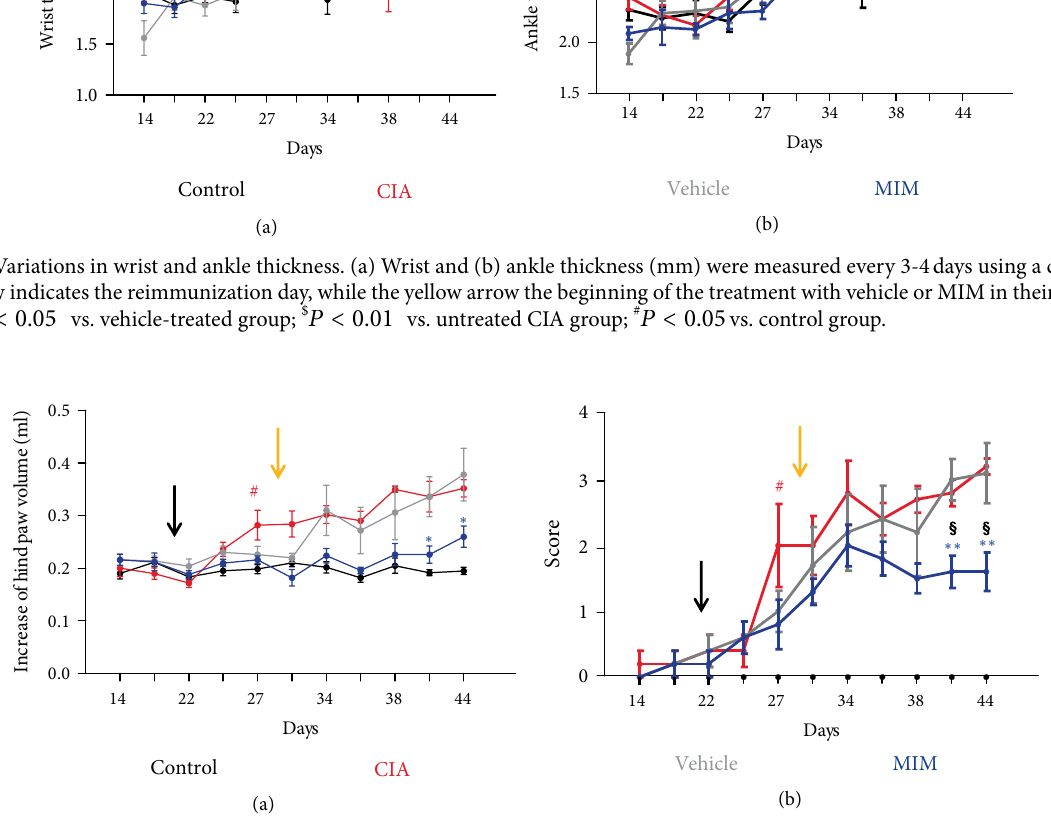
Figure 3: Variations in paw edema and clinical score. (a) Paw edema was measured as an increase in volume (ml), every 3-4 days using a plethysmometer. The black arrow indicates the reimmunization day, while the yellow arrow the beginning of the treatments. ∗ 푃 ≤ 0.05 vs. vehicle-treated group; # 푃 < 0.05 vs. control group. (b) Clinical score was attributed every 3-4 days for subjective evaluation of arthritis severity. The black arrow indicates the reimmunization day, while the orange arrow the beginning of the treatments. ∗∗ 푃 < 0.01 vs. vehicle-treated group; § 푃 < 0.01 vs. untreated CIA group; # 푃 < 0.05 vs. control